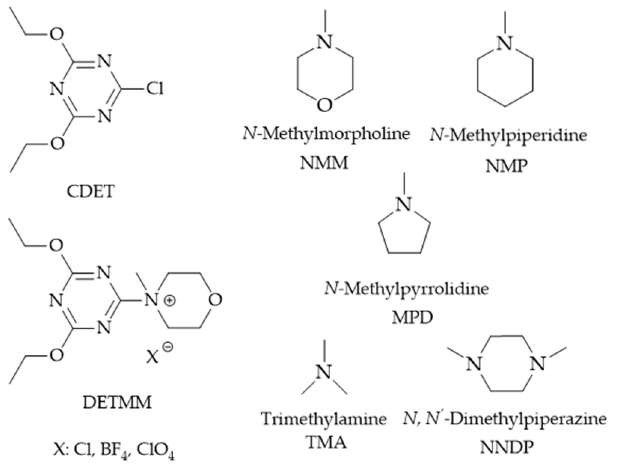
Figure 1. Chemical structure of CDET, DETMM(X), and different amine tested.